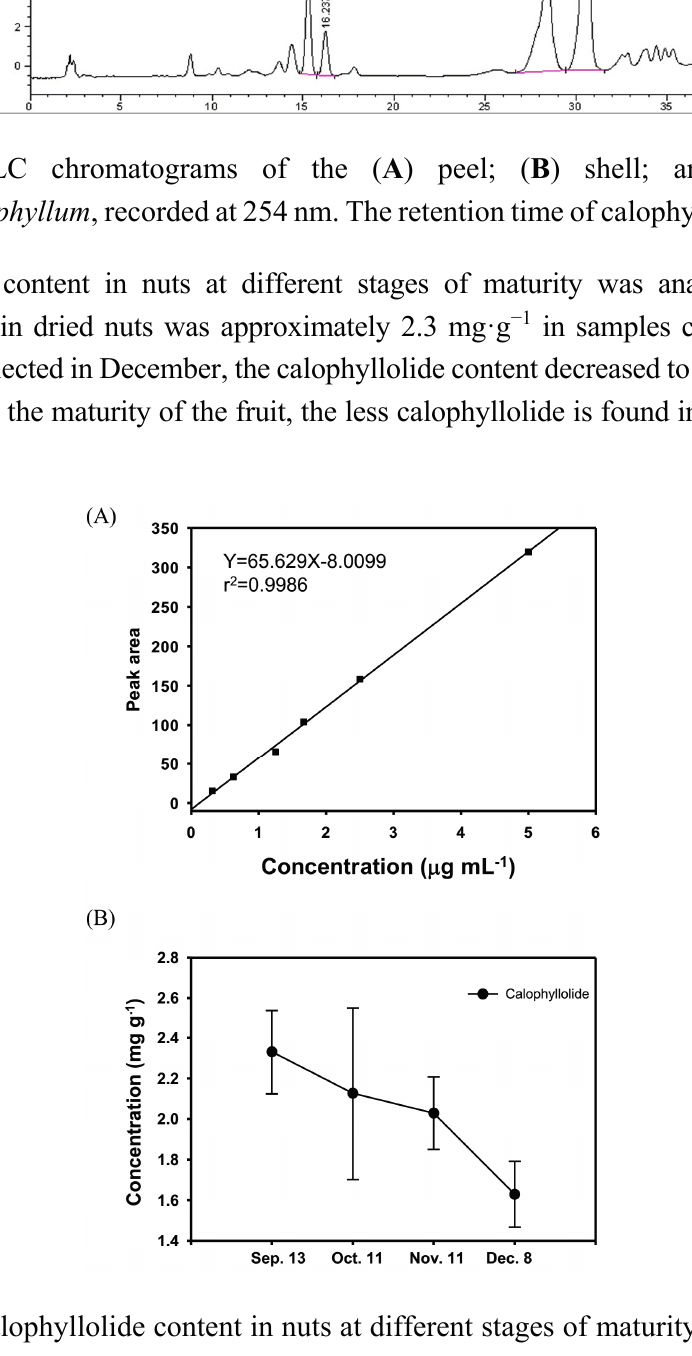
Figure 3. The calophyllolide content in nuts at different stages of maturity. ( A ) The HPLC standard curve of calophyllolide for quantification; ( B ) The contents of calophyllolide in nuts of C. inophyllum during maturation (from 13 September to 8 December). The data are shown as the mean ±